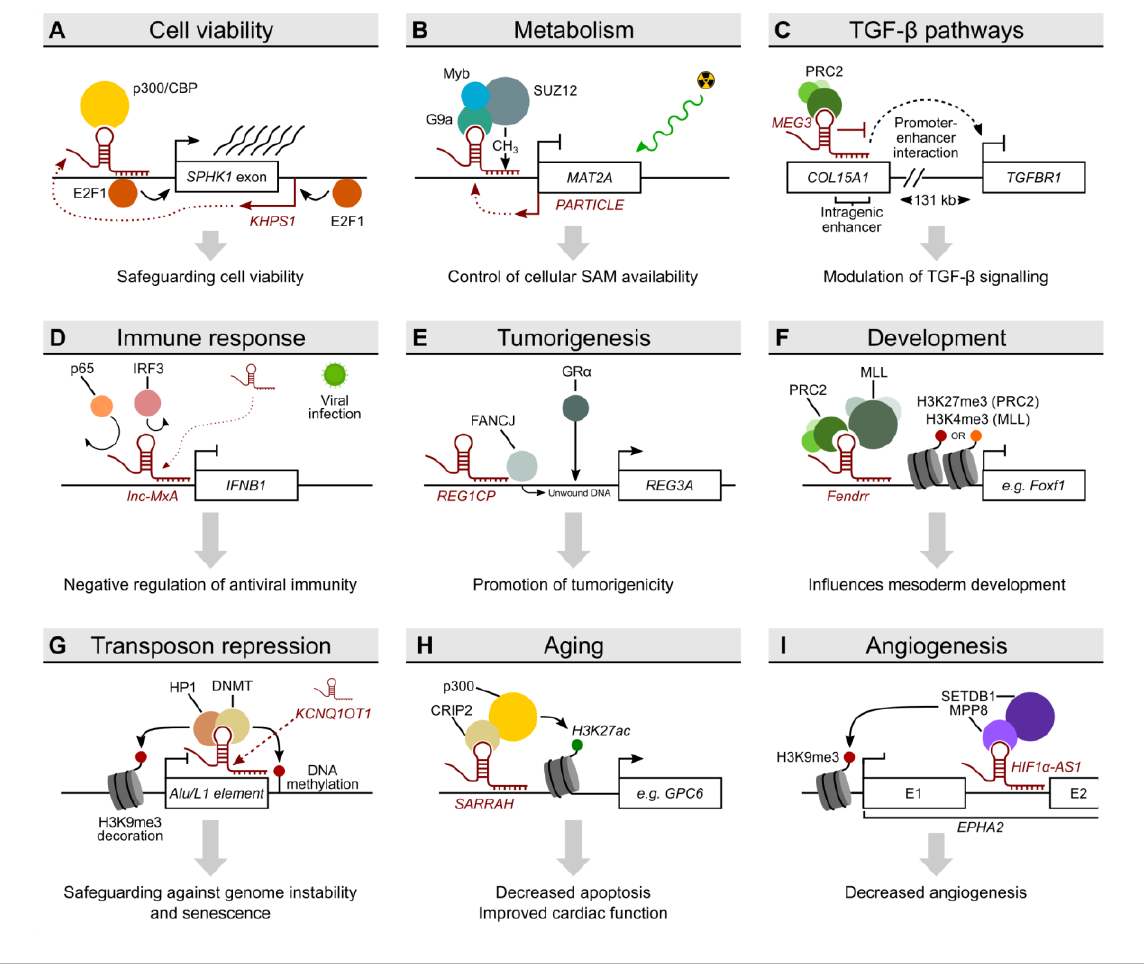
Figure 3. DNA:DNA:RNA triplex interactions and their proposed mechanisms of action ( A ) Triplex formation in cis by the lncRNA KHPS1. Through interactions with the transcription factors p300/CBP and E2F1, KHPS1 enhances the transcription SPHK1 . ( B ) Binding of the antisense lncRNA